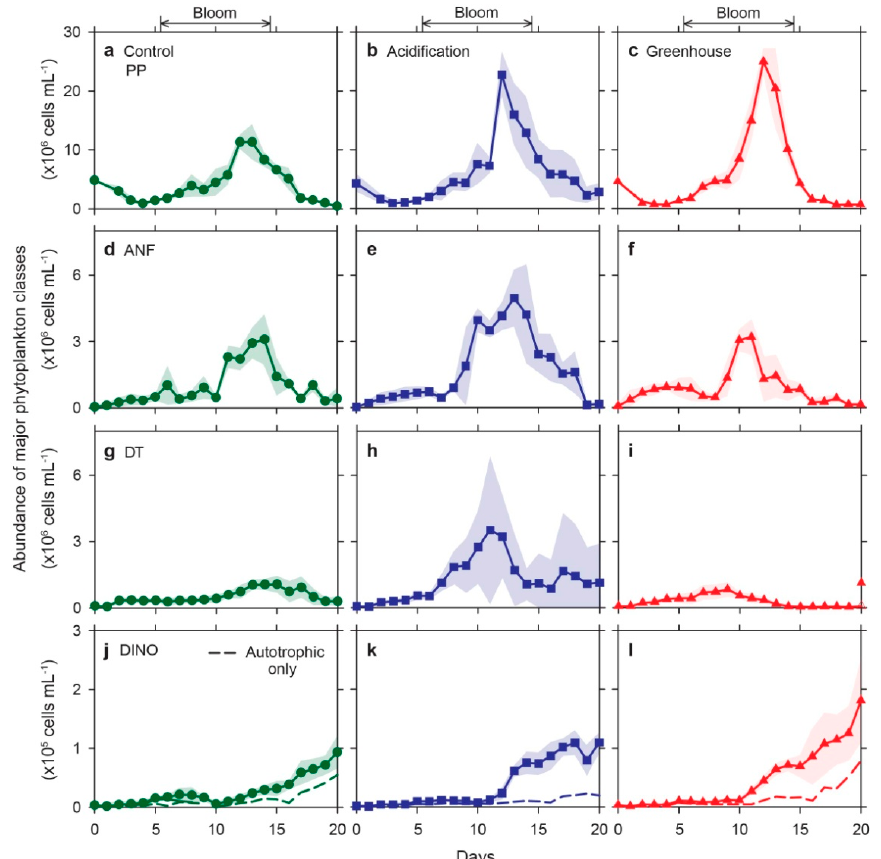
Figure 4. Changes in the cell abundance of major phytoplankton classes during the study period: ( a – c ) picoplankton, ( d – f ) autotrophic nanoflagellates, ( g – i ) diatoms, and ( j – l ) dinoflagellates. The symbols and the color shading represent the same as shown in Figure 2.